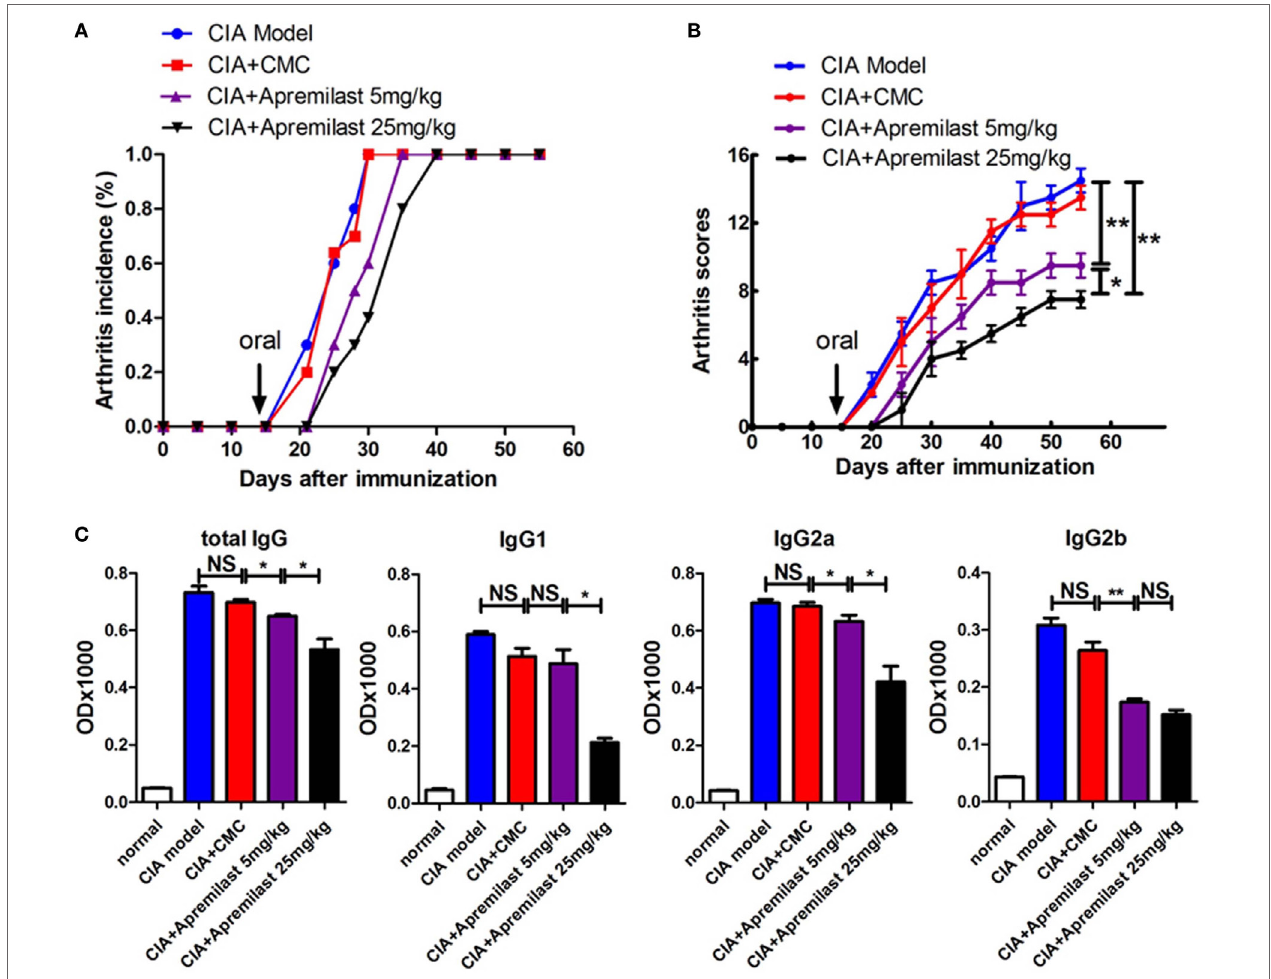
FigUre 1 | Apremilast delayed arthritis onset and reduced arthritis scores in the collagen-induced arthritis (CIA) model. DBA/1J-FoxP3 gfp mice were immunized with type II collagen emulsified with Freund’s complete adjuvant. On day 14 after immunization, Apremilast (5 or 25 mg/kg) was given orally once daily for 10 days. Vehicle alone (0.5% carboxymethyl cellulose, 0.25% Tween 80, CMC) was administered by oral gavage as a negative control. (a) The incidence of arthritis and (B) arthritis severity scores were determined at various time points after immunization. (c) Total serum IgG, IgG1, IgG2a, and IgG2b anti-mouse type II collagen antibody levels were measured by enzyme-linked immunosorbent assay. The data indicate the mean ± SEM of five mice per group from two independent experiments. Data were analyzed using the one-way ANOVA for comparison among multiple groups, followed by Turkey’s test (* p < 0.05, ** p <